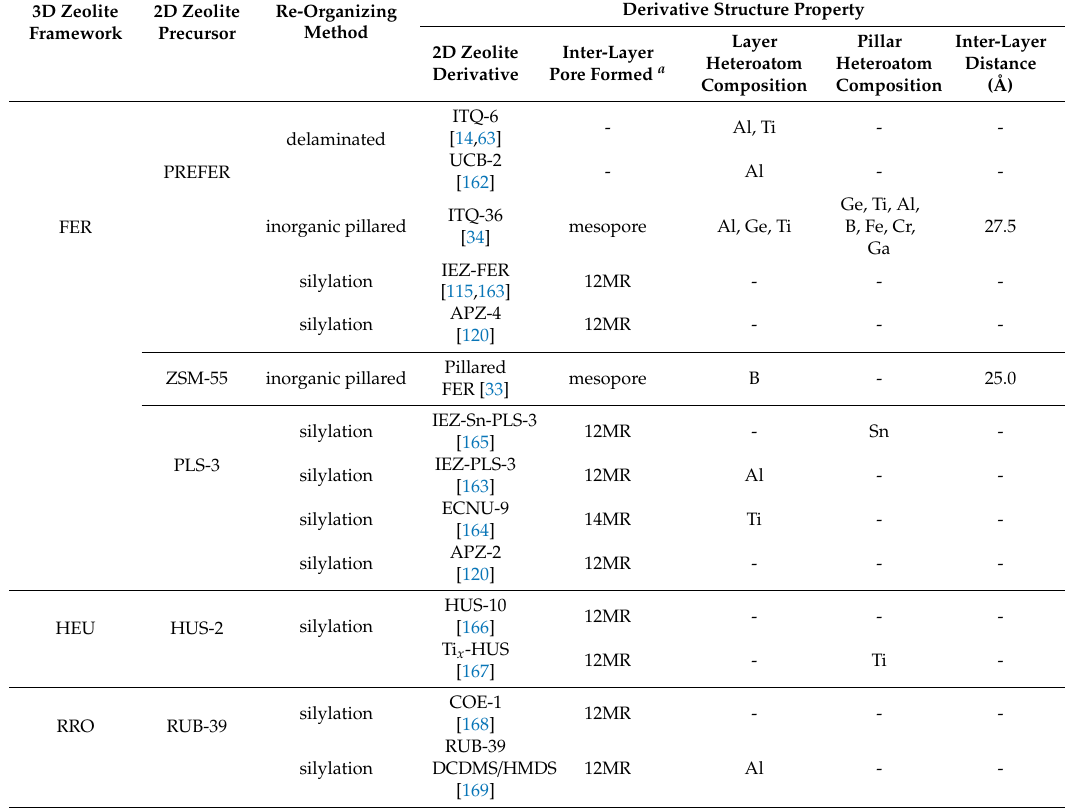
Table 5. Structural and compositional properties of derivatives of 2D FER, HEU (heulandite), and RRO (RUB-41 (forty-one))